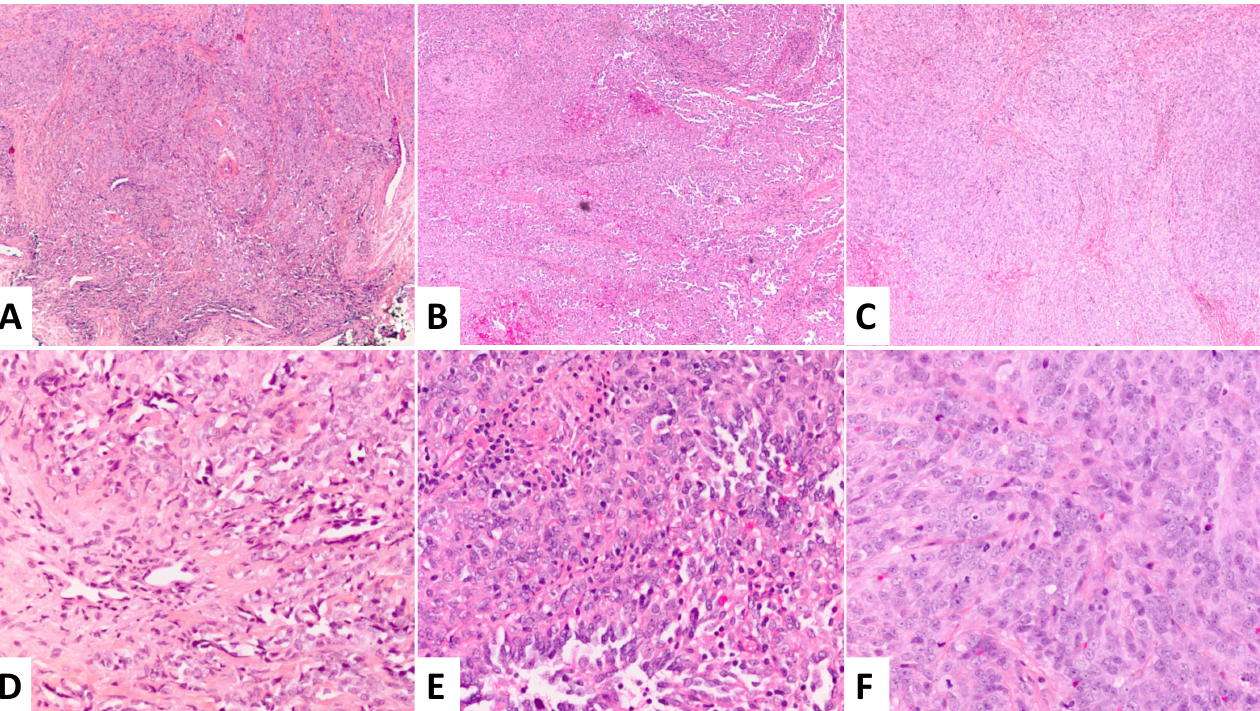
Figure 1. Morphologic features of the three lesions at 40× and 200× magnification. ( A , D ) Primary lesion in 2008 with admixture of retiform and epithelioid patterns and rare MFs. ( B,E ) First recurrent lesion in 2015 with increase in cellularity and cytologic atypia and 8 MFs/10 HPF. ( C,F ) Second recurrent lesion in 2017 with pleomorphism, prominent nucleoli, and >10 MFs/10 HPF.